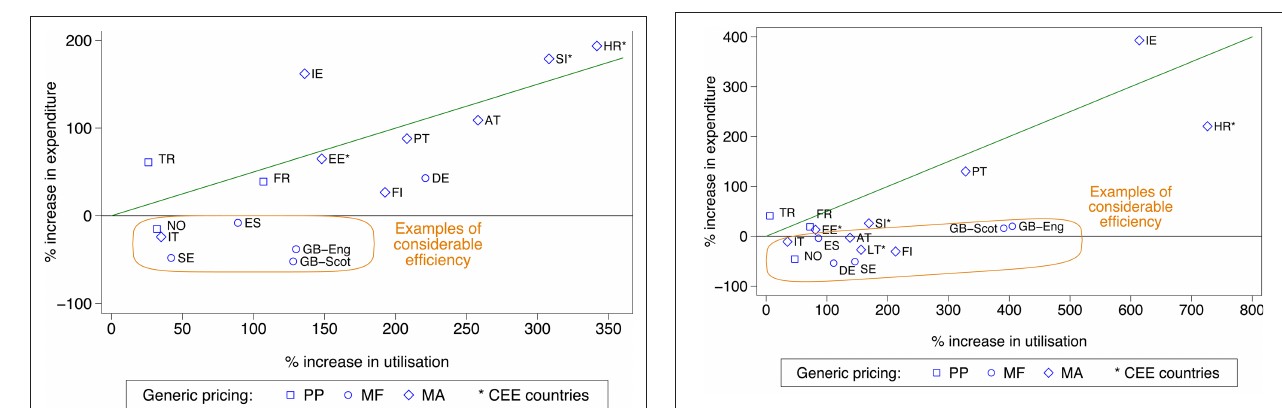
FIGuRE 1 | Rate of increase in expenditure (local currency) versus the rate of increase in utilization (DDD based) for the PPIs principally from 2007 versus 2001 among European countries (unless stated), with generic pricing approaches divided into three categories. Standard EU country abbreviations have been used. ES = Catalonia (2007 versus 2003), EE = 2007 versus 2004, HR = 2007 versus 2000, IT = 2008 versus 2006, NO = 2007 versus 2004, TR = 2009 versus 2007.